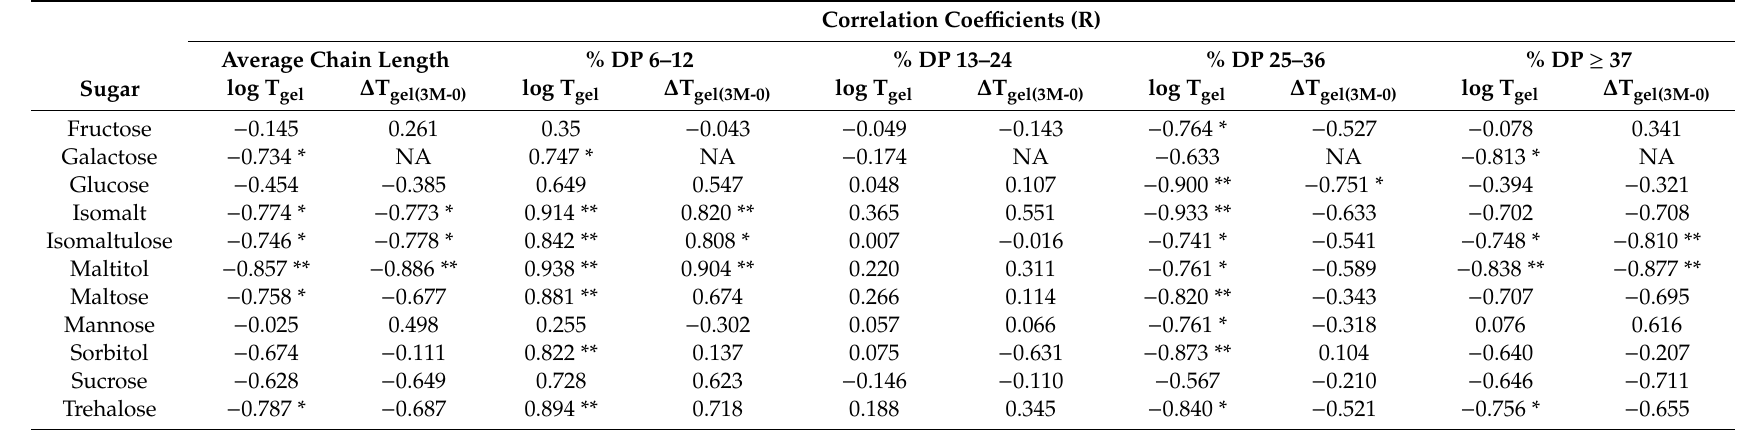
Table 5. Comparisons of correlation coe ffi cients (R) of slopes of log T gel vs. sweetener concentration (abbreviated log T gel in table) and ∆ T gel( i- 0) s in solutions of 3